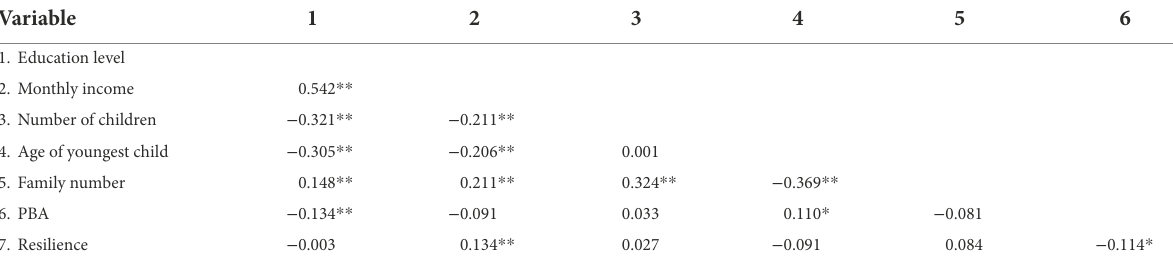
TABLE 2 Correlations among variables ( N = 390).